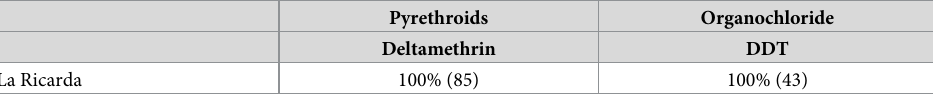
Table 4. Insecticide susceptibility of Ae . caspius collected from Baix Llobregat (Barcelona, Spain) in 2017. Per- centage indicates percent mortality at discriminating exposure time of 30 min (45 min for DDT); number between parentheses indicates the number of mosquitoes